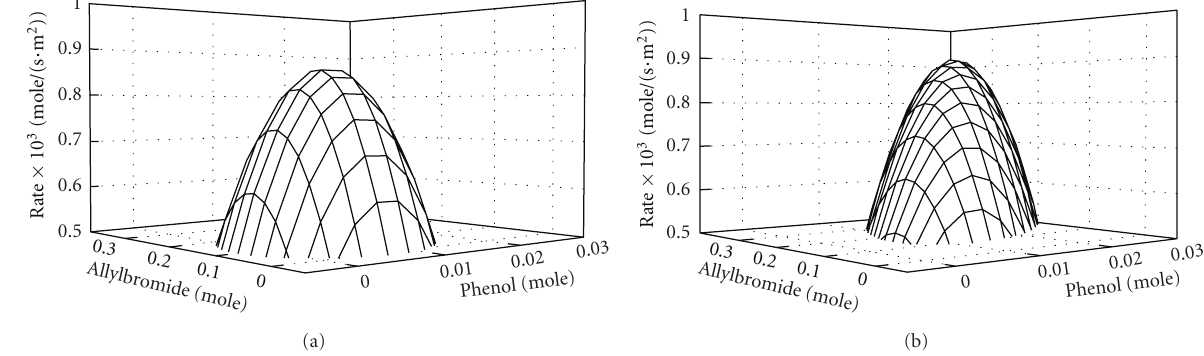
Figure 4: Respond surface of reaction in membrane reactors (a) H1 and (b) H2.